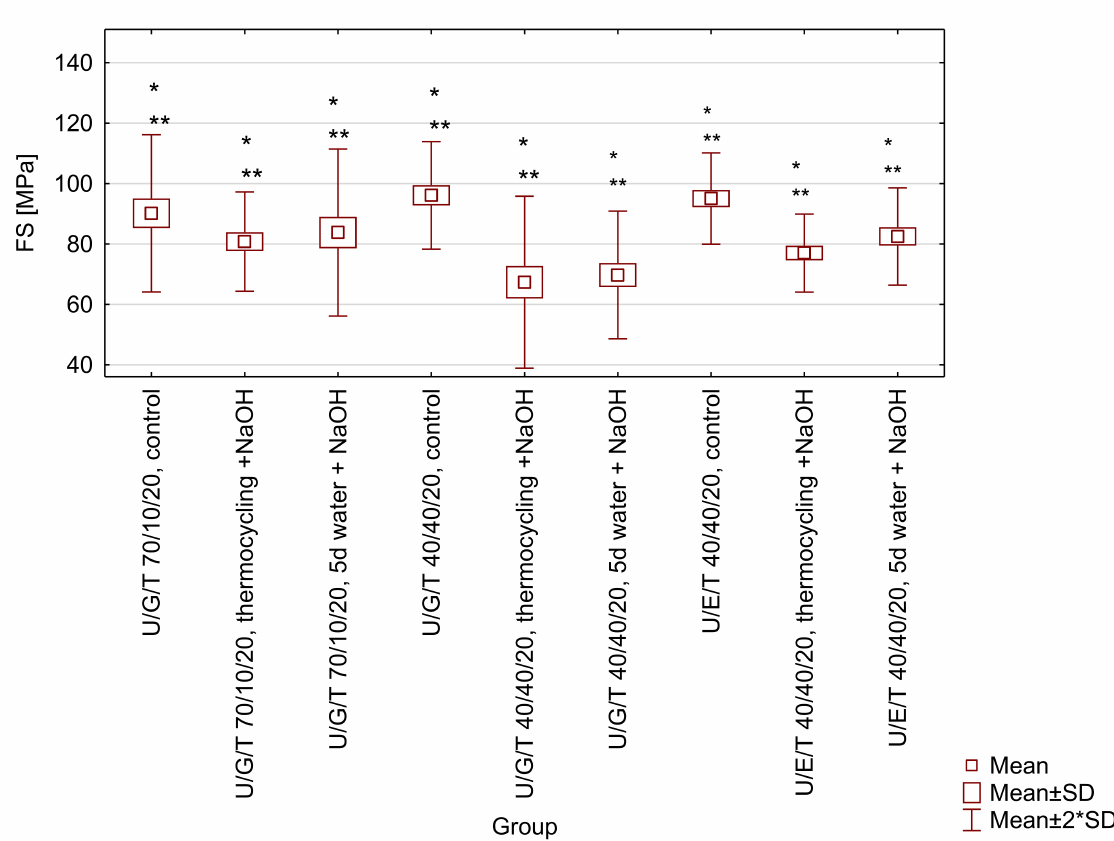
Figure A4. Box-and-whisker plot of three-point bending flexural strength (FS) of tested composites (UDMA/Bis-GMA/TEGDMA 70/10/20 wt.% and 40/40/20 wt.% and UDMA/Bis-EMA/TEGDMA 40/40/20 wt.%) after selected aging protocols (control-water, 24 h, 37 ◦ C; thermocycling + NaOH- water, 7500 thermo cycles, 5/55 ◦ C and 0.1 M NaOH, 7 days, 60 ◦ C; 5d water + NaOH-water, 5 days, 55 ◦ C and 0.1 M NaOH, 7 days). Significant differences occur in a given group with a probability of p < 0.01 (*) and/or p < 0.05 (**). Table A3. Probabilities for post hoc testing for three-point bending flexural strength (FS) of tested composites. Tested group: 1-UDMA/bis-GMA/TEGDMA 70/10/20, control; 2-UDMA/bis- GMA/TEGDMA 70/10/20, thermocycling +NaOH, 3-UDMA/bis-GMA/TEGDMA 70/10/20, 5d water + NaOH, 4-UDMA/bis-GMA/TEGDMA 40/40/20, control; 5-UDMA/bis-GMA/TEGDMA 40/40/20, thermocycling +NaOH; 6-UDMA/bis-GMA/TEGDMA 40/40/20, 5d water + NaOH; 7-UDMA/bis-EMA/TEGDMA 40/40/20, control; 8-UDMA/bis-EMA/TEGDMA 40/40/20, thermo- cycling +NaOH, 9-UDMA/bis-EMA/TEGDMA 40/40/20, 5d water + NaOH.